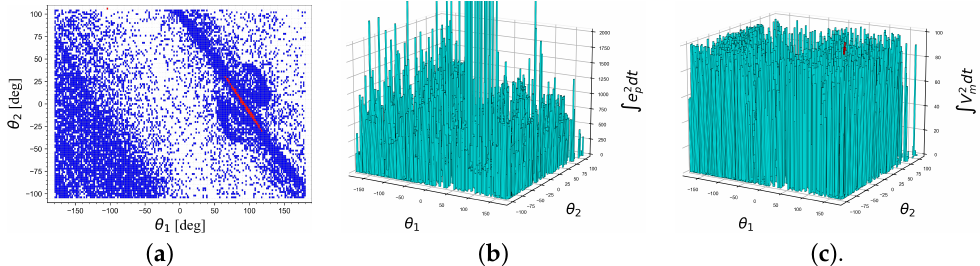
(cid:82) (cid:82) e 2 p dt , ( c ) V 2 m